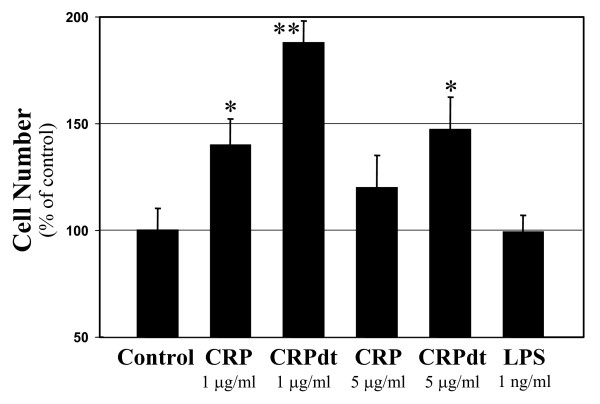
CRP stimulated BAEC proliferation. The effect of 1–5 μg/ml CRP (non-detoxified and detoxified CRP [CRPdt]) for 72 h on BAEC proliferation is shown. Experiments were repeated at least twice in triplicate wells. * and ** indicate a statistically significant difference compared with the control cells (p > 0.05 and 0.001 respectively).